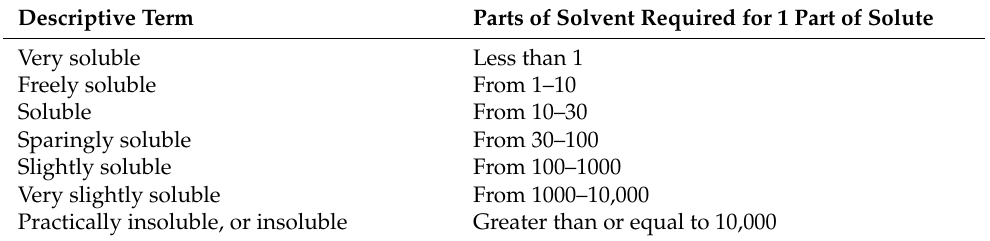
Table 1. United States Pharmacopeia solubility